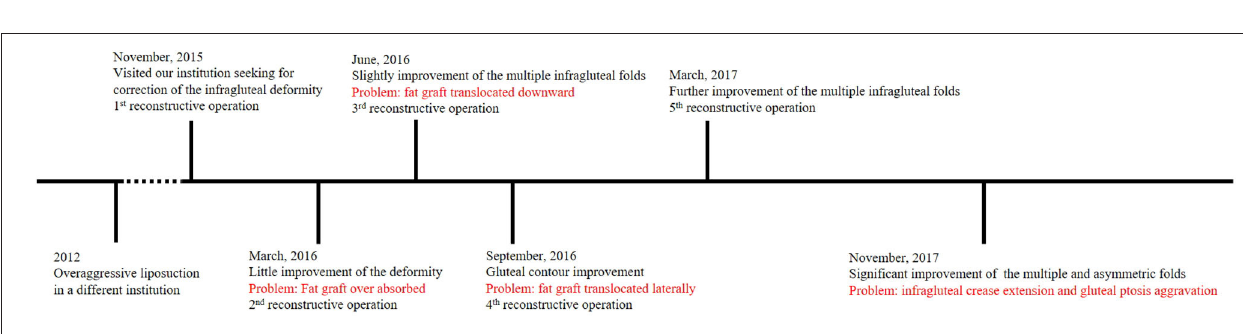
FIGURE 4 | An outline of the reconstructive